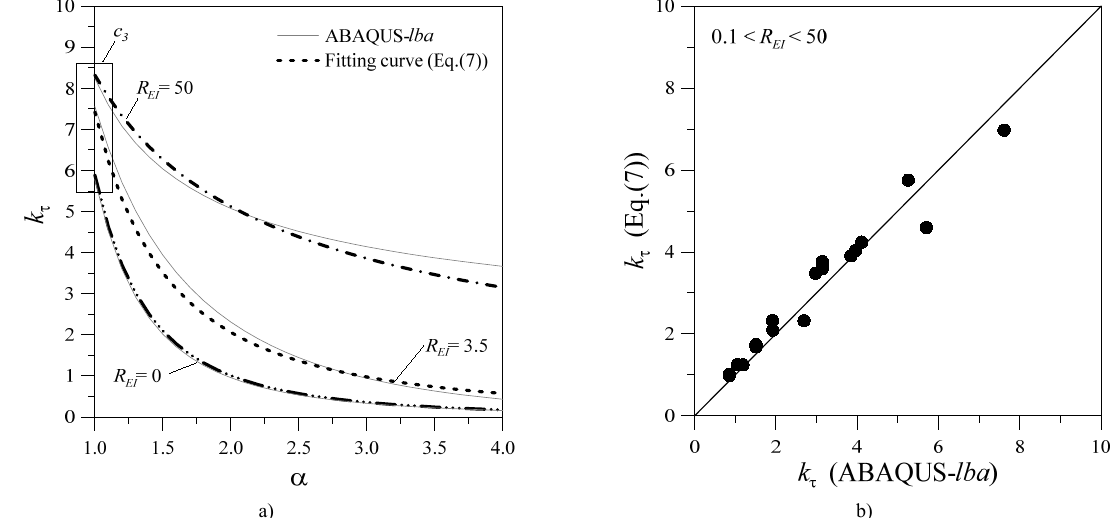
Fig. 5 FE numerically derived and analytical fitting curves for frame supported glass shear walls. a) k  buckling coefficients and b) FE-analytical comparisons.